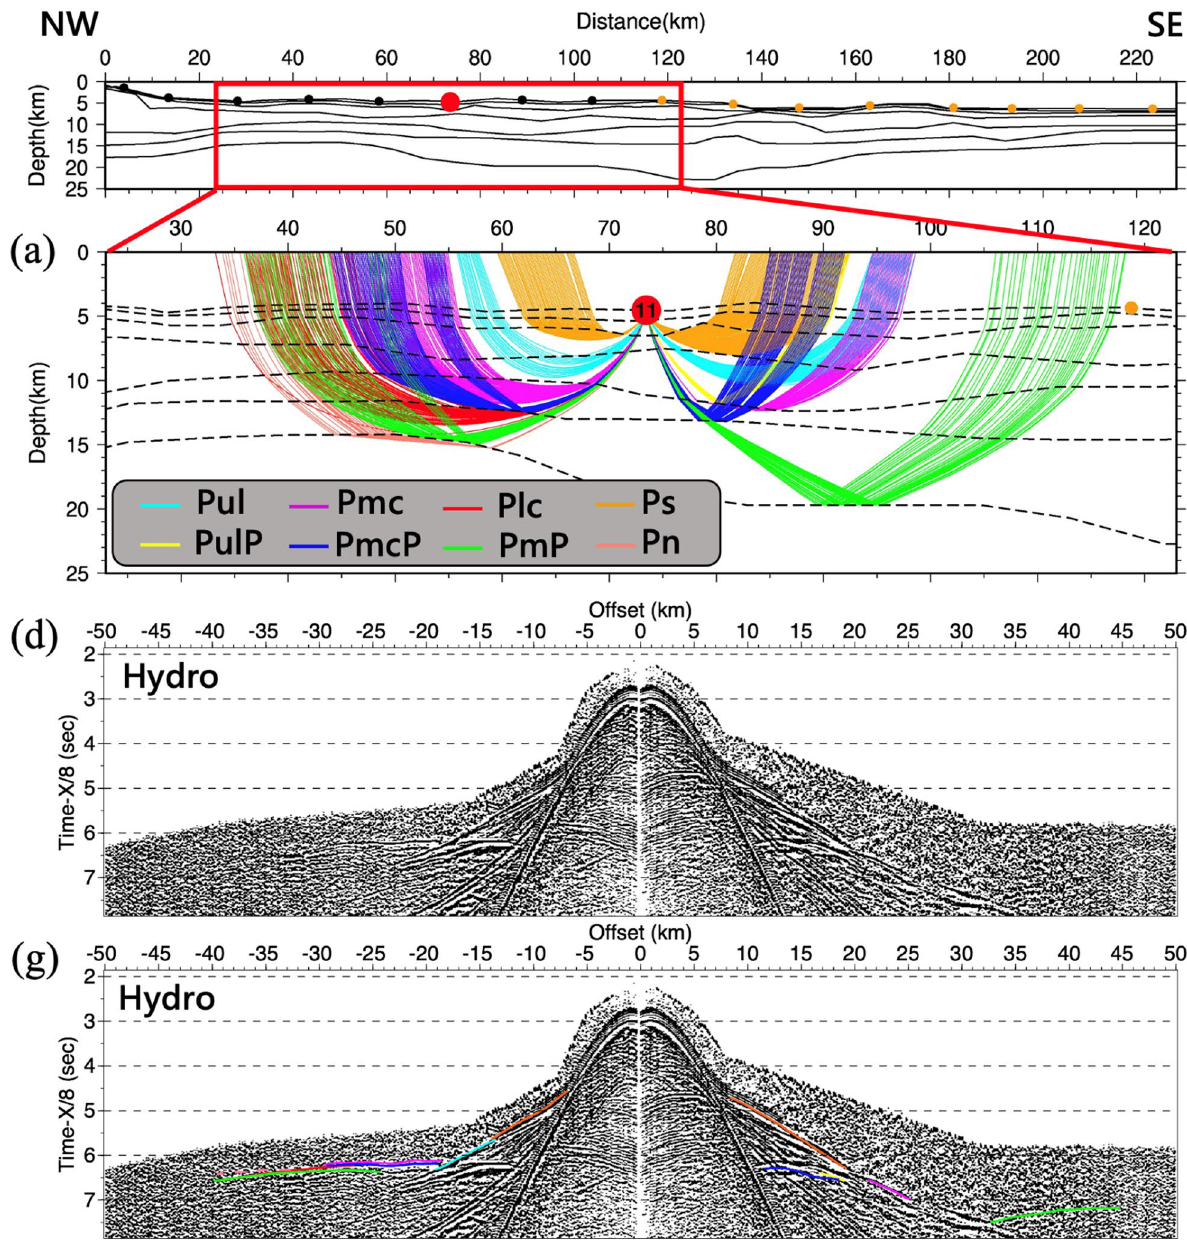
Fig. 7 The ray coverage of the picked arrivals from a OBS11, b OBS06, and c OBS03 station along MGL0906‑19. The hydrophone component of d OBS11, e OBS06, and f OBS03 data without interpretation along MGL0906‑19. The picked arrivals propagating through the crust superimposed on the g OBS11, h OBS06, and i OBS03 data along MGL0906‑19. The OBS images of the blue and red frames respectively at the NW and SE offsets are zoomed in. Ps: arrivals refracted through the sediment; Pul: arrivals refracted through the upper layer (the upper crust or the accretionary prism); Pmc: arrivals refracted through the middle crust; Plc: arrivals refracted through the lower crust; PulP: arrivals reflected at the bottom of the upper layer (the upper crust or the bottom of the Ryukyu accretionary); PmcP: arrivals reflected at the intra‑crustal interfaces; PmP: arrivals reflected at Moho. The dashed lines indicate less reliable